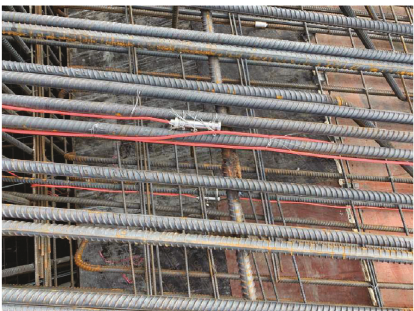
Figure 5: Installation diagram of a group of concrete stress gauges.